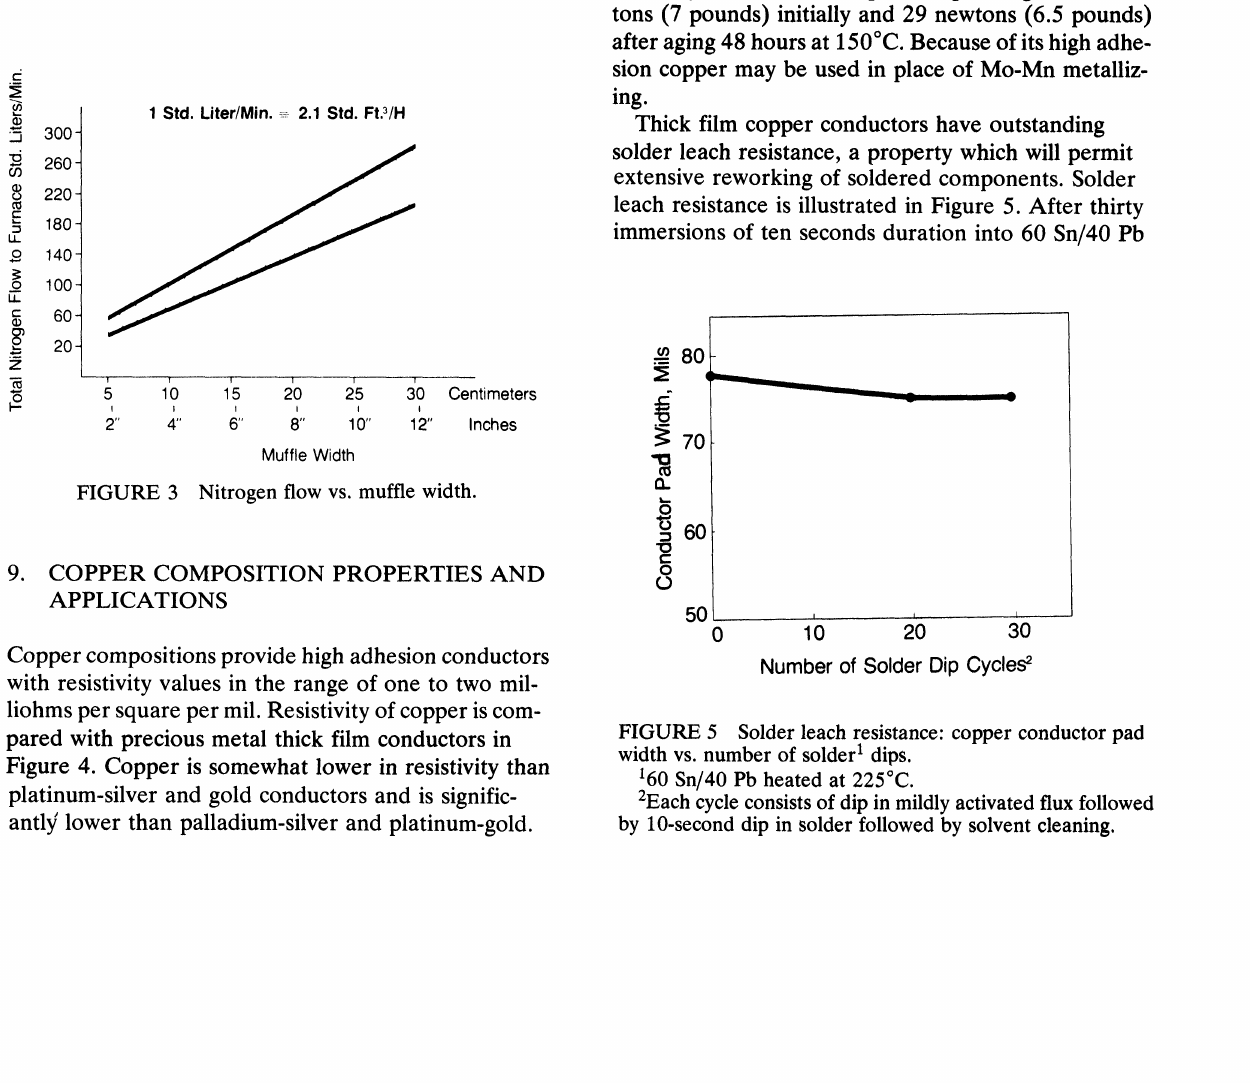
FIGURE 4 Resistivity of thick film copper vs. typical preci- ous metal thick film conductors.